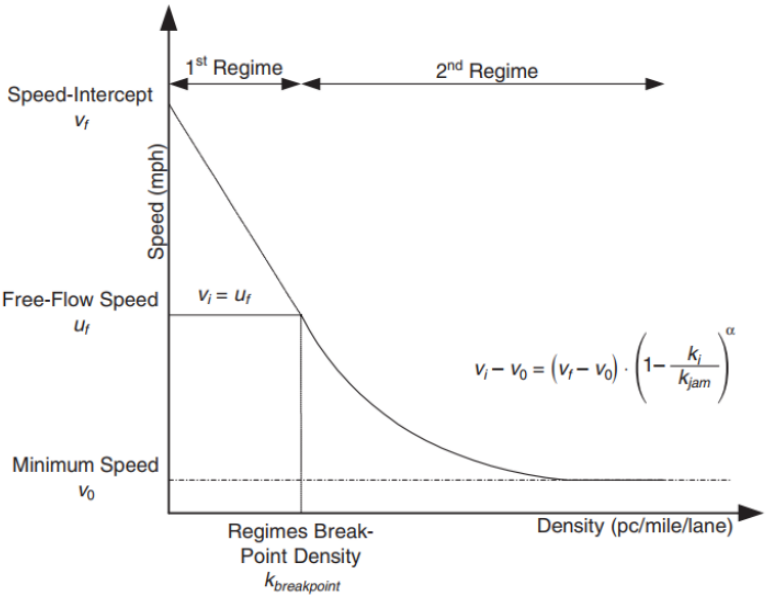
Figure 1. The dual-regime modified Greenshields traffic flow model of